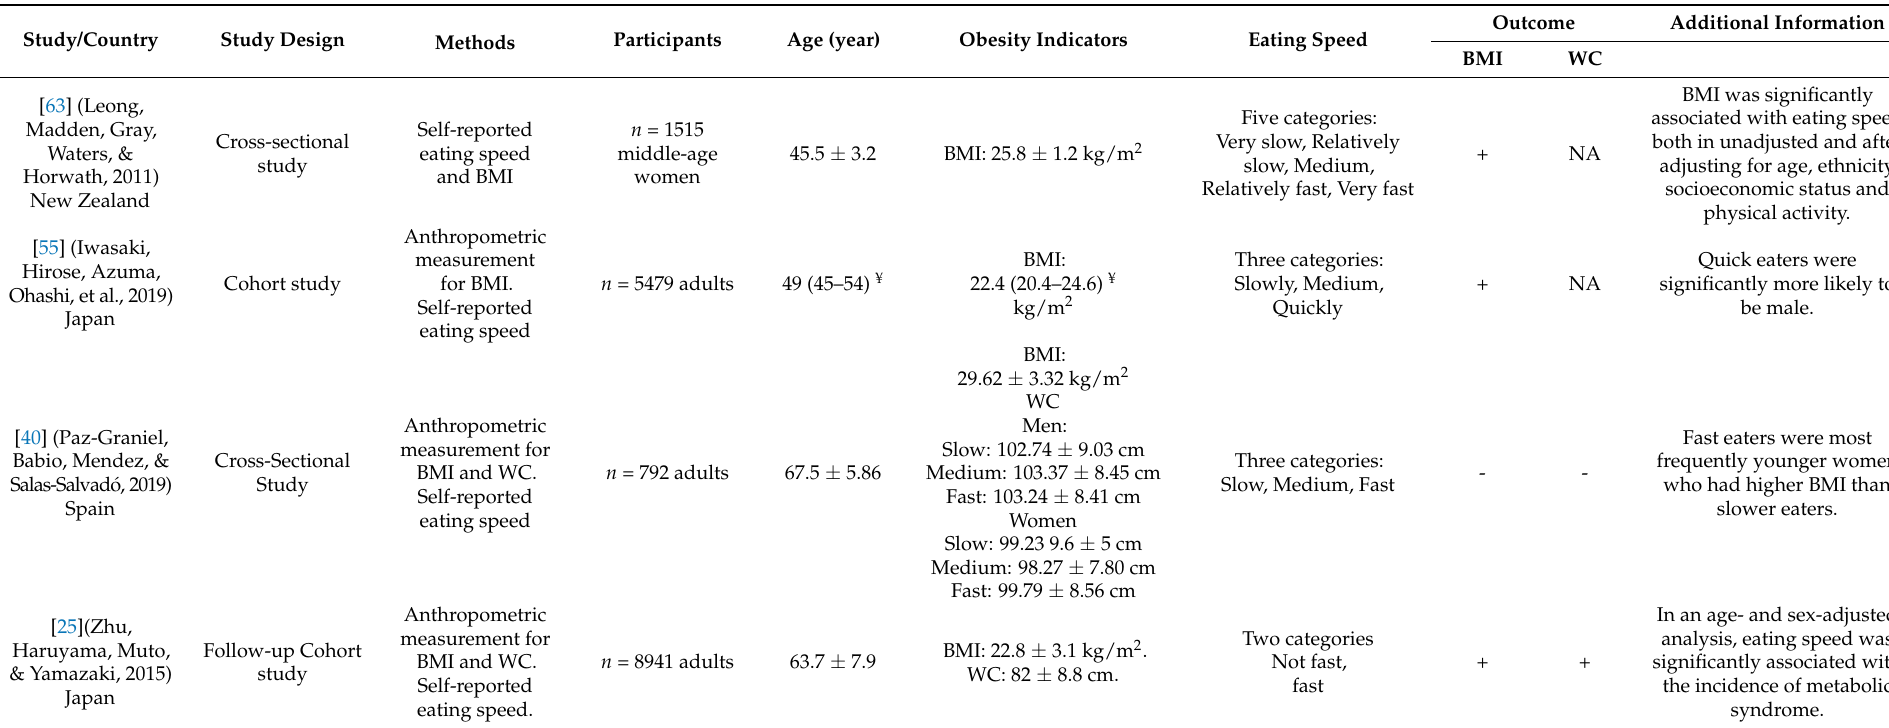
Table 2. Summary of the design and results from articles investigating the relationship between eating speed and obesity indicators in the general population.